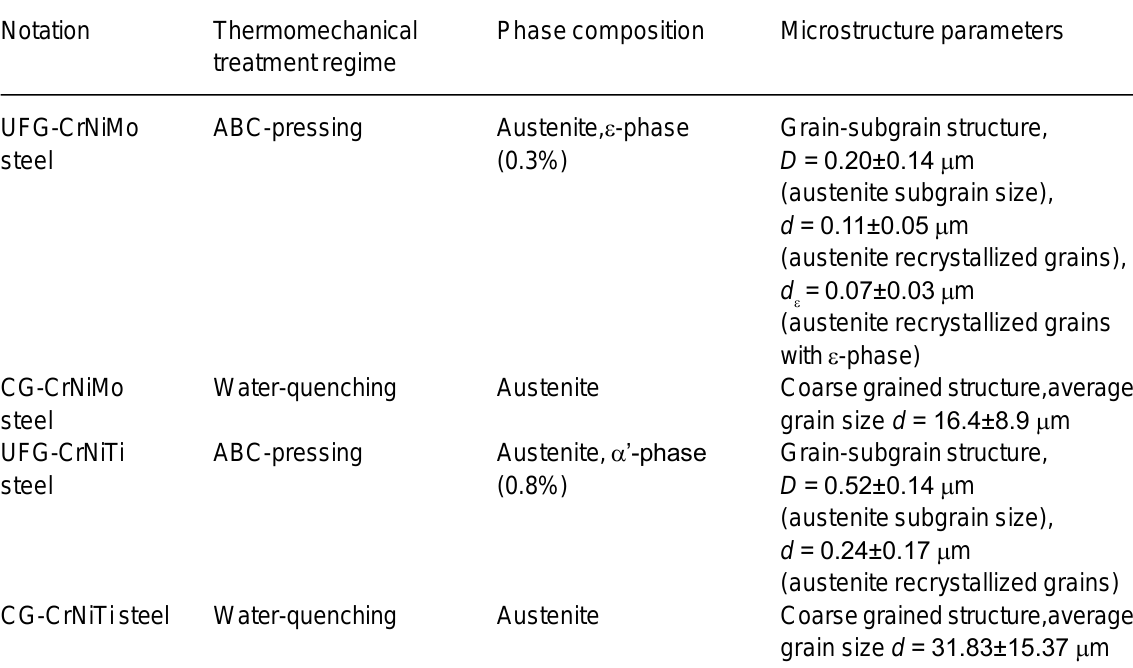
Table 2. Phase composition and microstructure parameters of the steels prior to